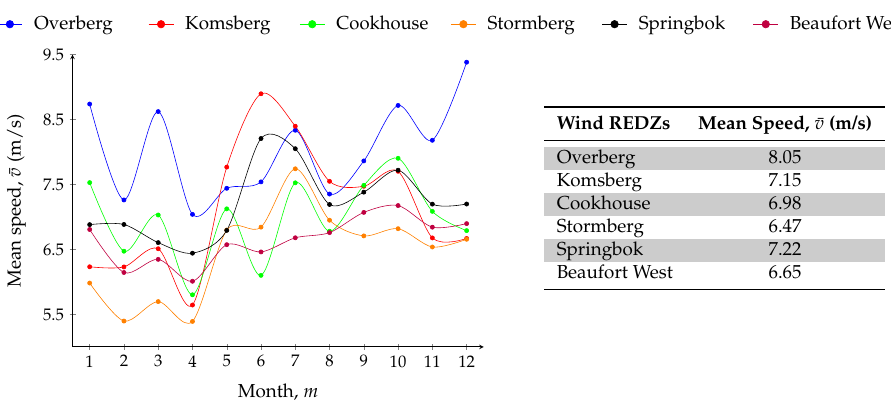
Figure 7. Monthly mean speed ( left ) and annual mean speed ( right ) of wind REDZs.